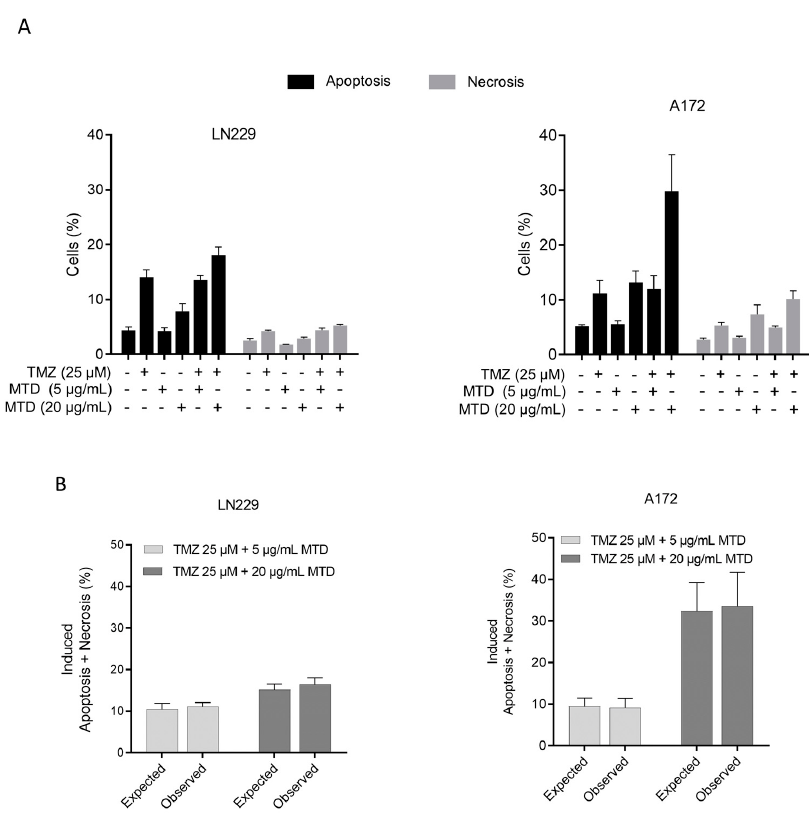
Figure 8. Effect of MTD on TMZ-induced apoptosis and necrosis, measured by AV/PI flow cytometry. ( A ) Percentage of apoptotic and necrotic cells in the population, determined 120 h after treatment. Data are the mean of three independent experiments. ( B ) TMZ-MTD induced cell death (apoptosis/necrosis). Observed levels after combined treatment and expected frequencies on the basis of additivity of single-drug treatment.